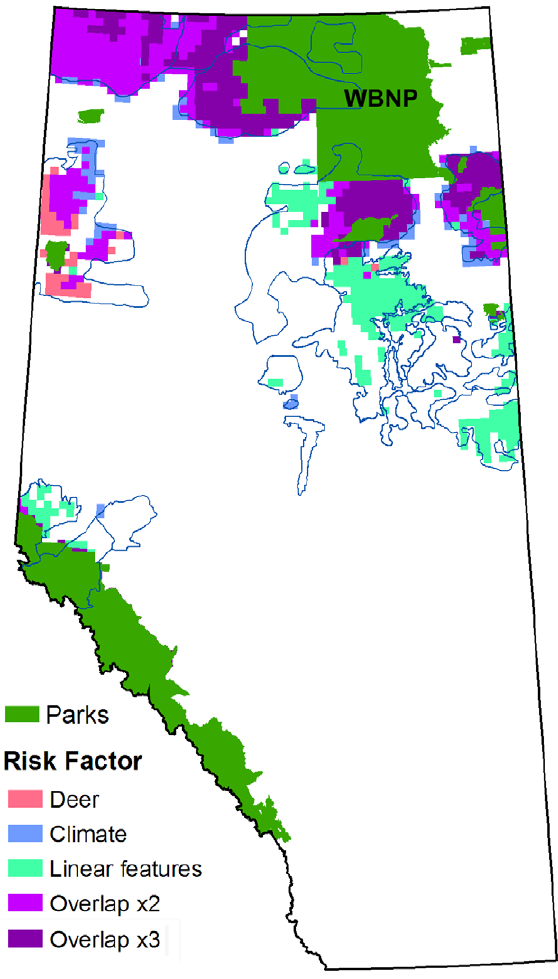
Figure 3. Planning units selected in Scenario 1. The map represents a composite of three model runs, one for each of the demographic risk factors. The caribou protection target was 50% in all cases. Units that were selected by more than one model are labelled as ‘‘Overlap’’. For clarity, only planning units with a high probability of selection ( . 50%) are